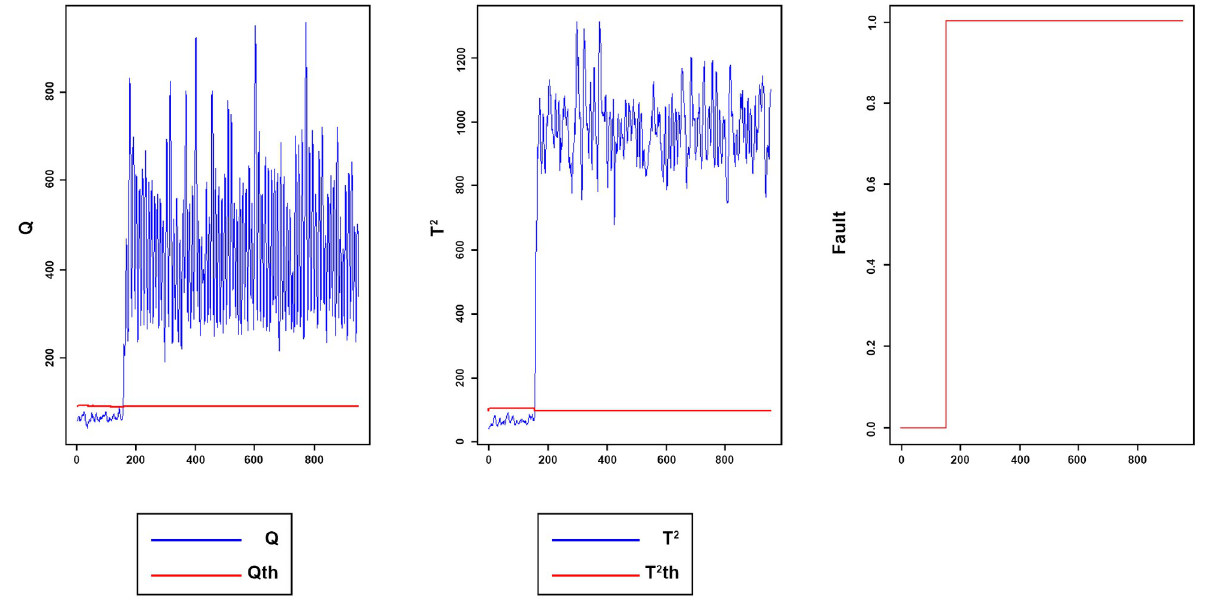
Fig 14. Monitoring performance of MWDPCA for fault